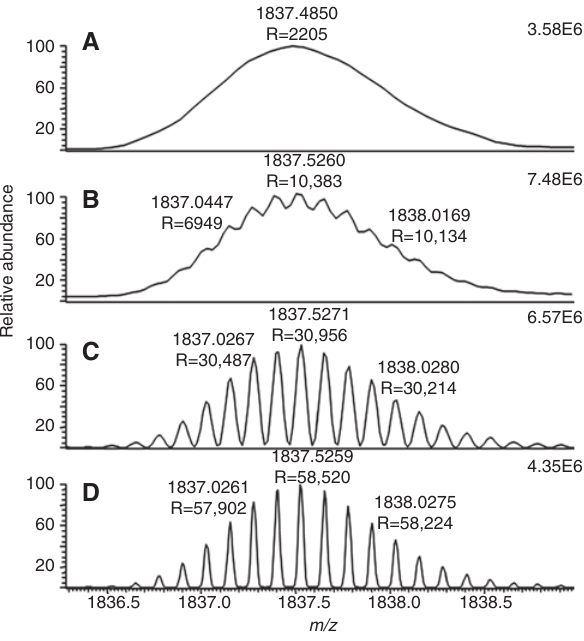
Figure 4 Effect of resolving power on separation of isotopic peaks of octuply charged lysozymes. (A) Resolving power of 2k, (B) resolv- ing power of 10k, (C) resolving power of 30k, and (D) resolving power of 60k (reproduced from Ruan et al. 2011, with permission).